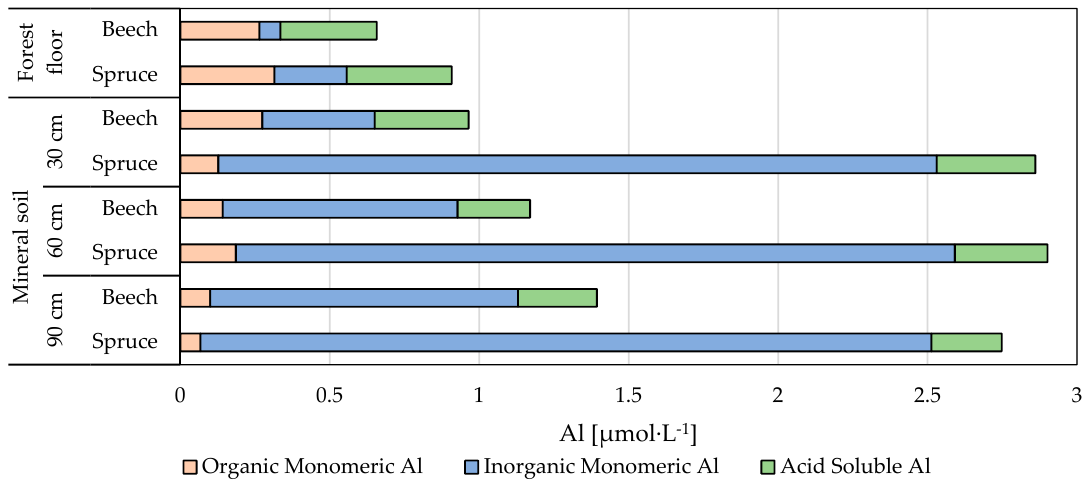
Figure 3. Mean concentrations of Al fractions in the soil solution from the forest floor and from the mineral soil in the soil water in different depths (upper column—beech, lower column—spruce).